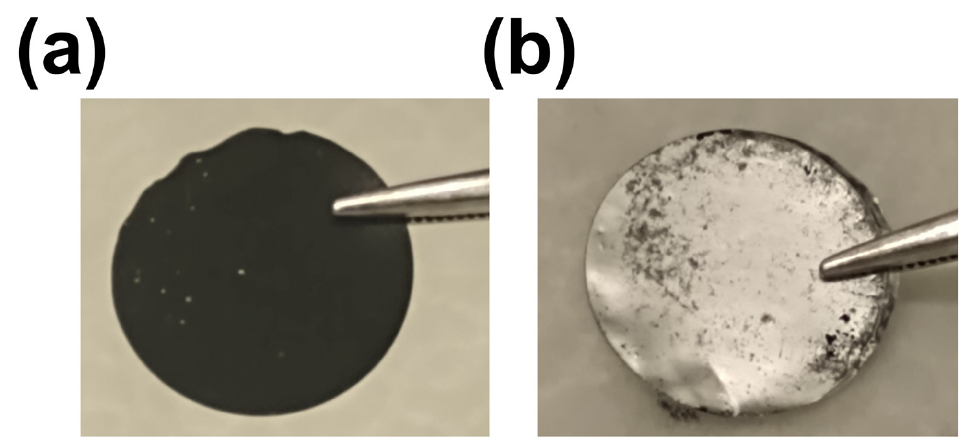
Figure 7. LNMO-TG electrode: ( a ) before; ( b ) after ultrasonic-bath delamination process for 30 s at 37